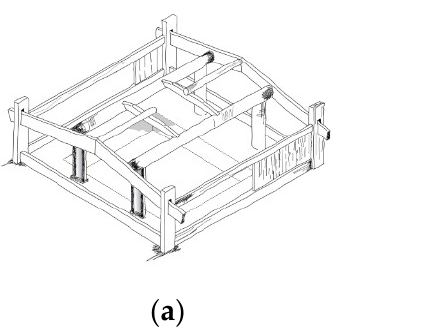
Figure 2. Plan of Ninstints (dwelling number 3 in red) [6] (p. 10).